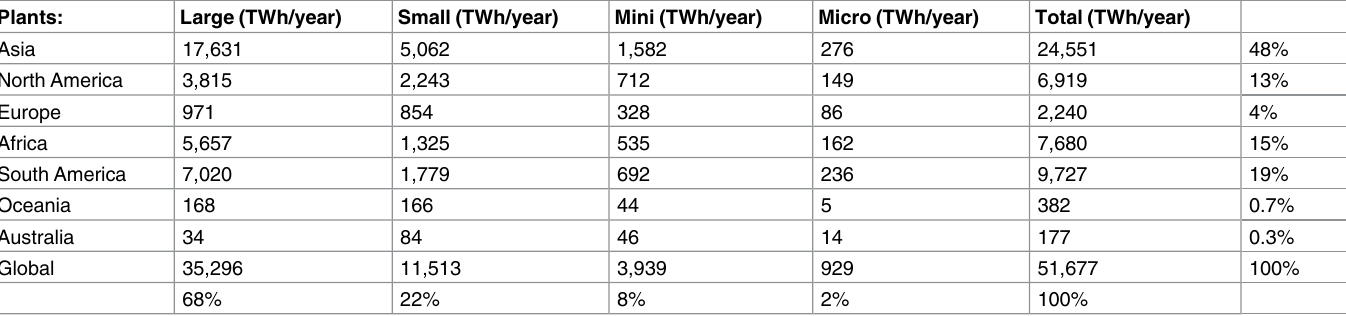
Table 2. Hydropower potential per continent and its distribution among large, small, micro and mini plant sizes. Plants: Large (TWh/year) Small (TWh/year) Mini (TWh/year) Micro (TWh/year) Total (TWh/year) Asia 17,631 5,062 1,582 276 24,551 48% North America 3,815 2,243 Europe 971 854 328